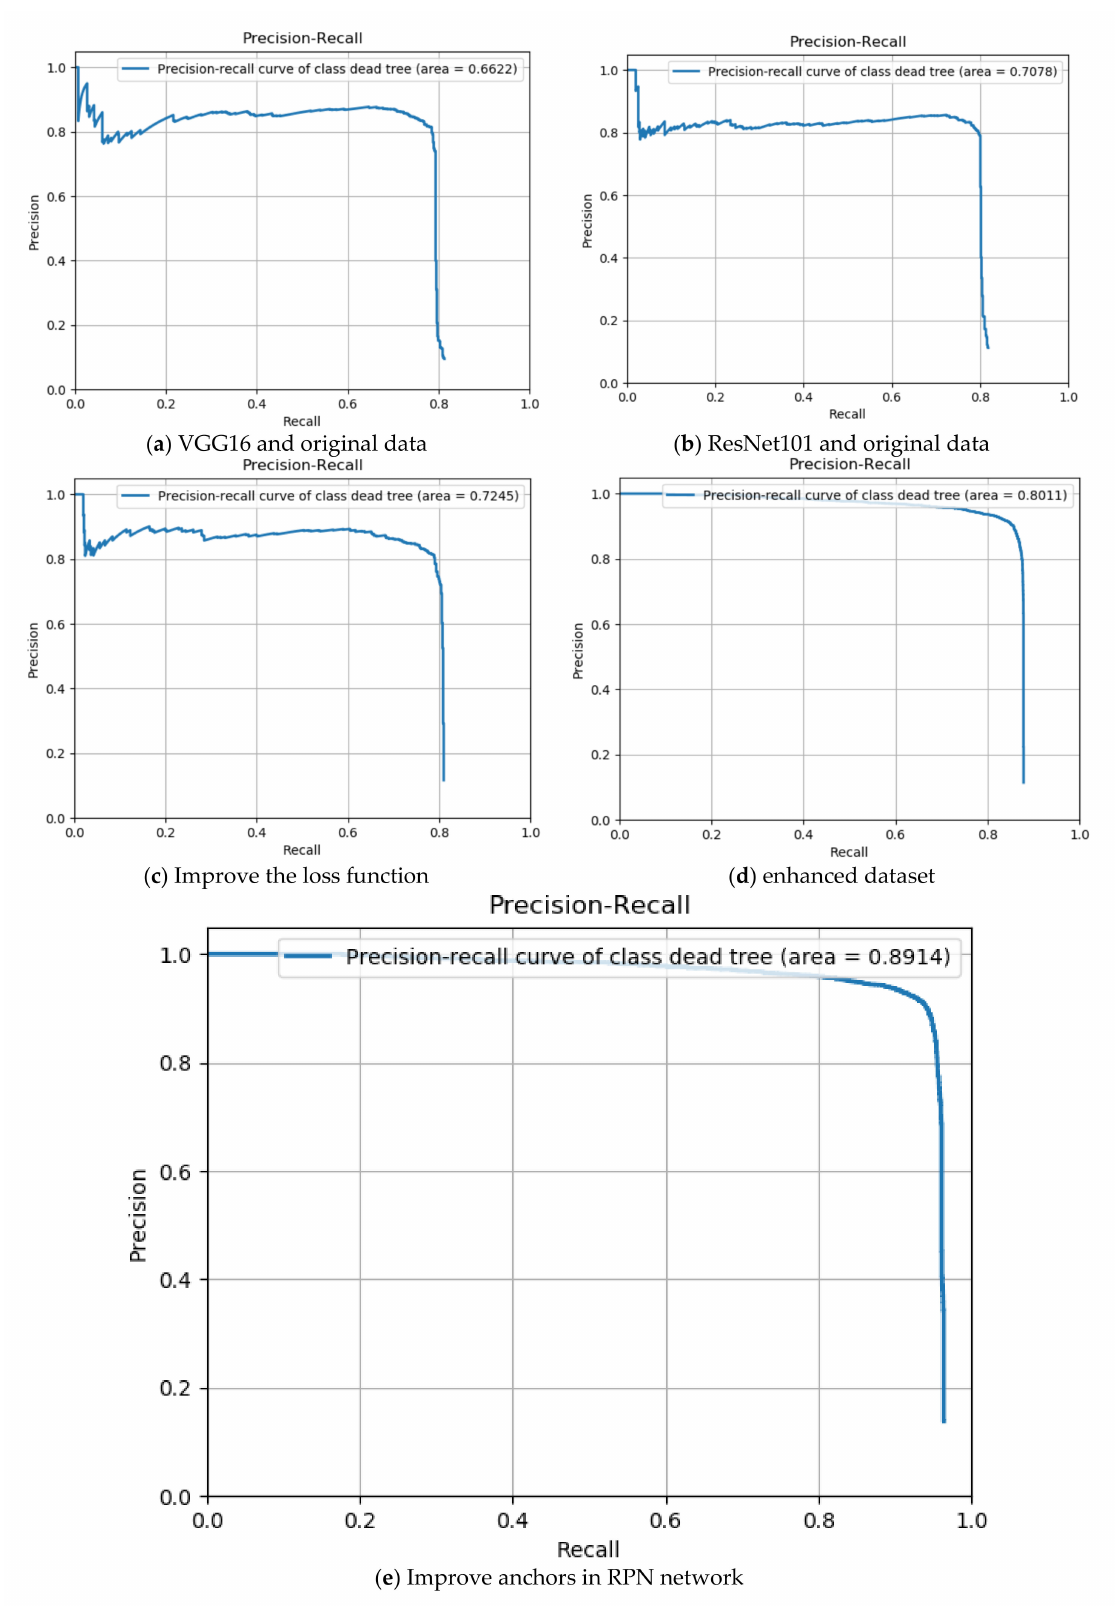
Figure 7. Precision–recall curve of models in di ff erent improvement